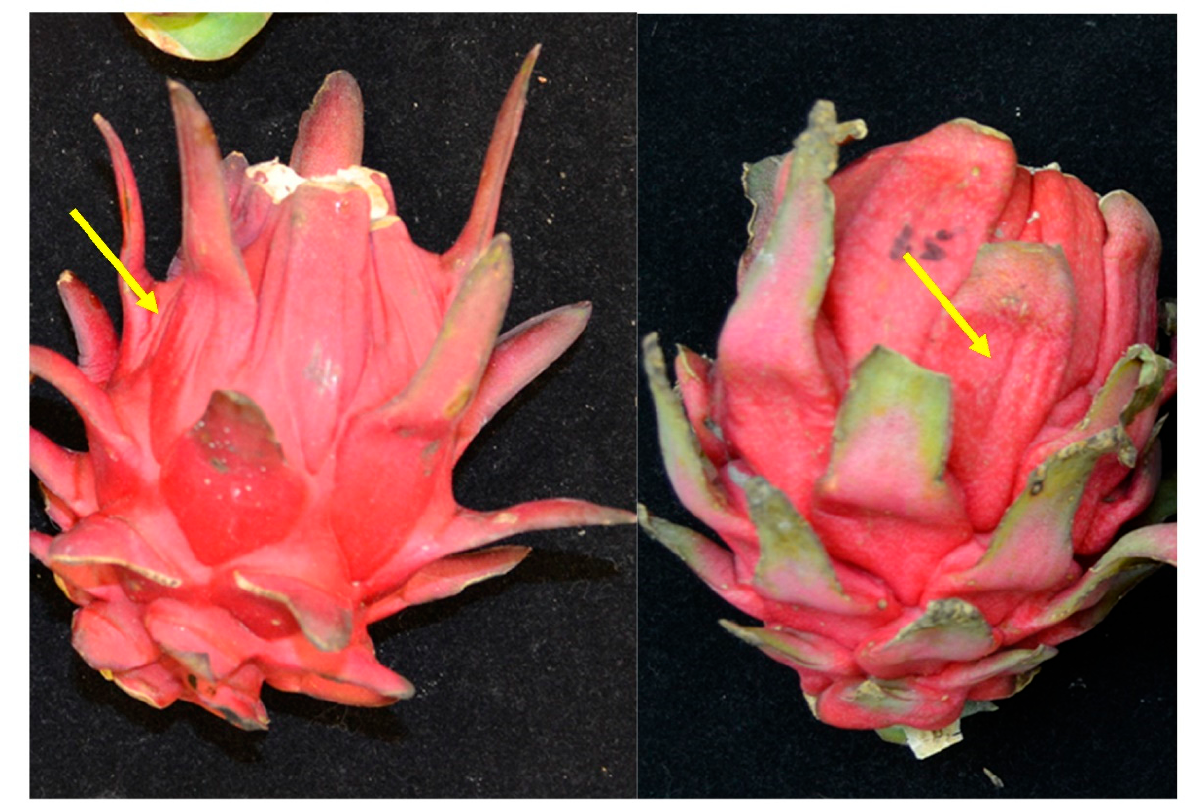
Figure 1. Scale shriveling in uncoated pitaya fruit after 20 days storage at 7 °C. Yellow lesions began to appear by Day 15, at which time severity ranged from 2% to 10%; by day 20 lesions increased to 15.5% to 20.0% (Table 1). These were diagnosed as Colletotrichum gloeosporioides , also known as anthracnose fruit rot (Plant Diagnostic